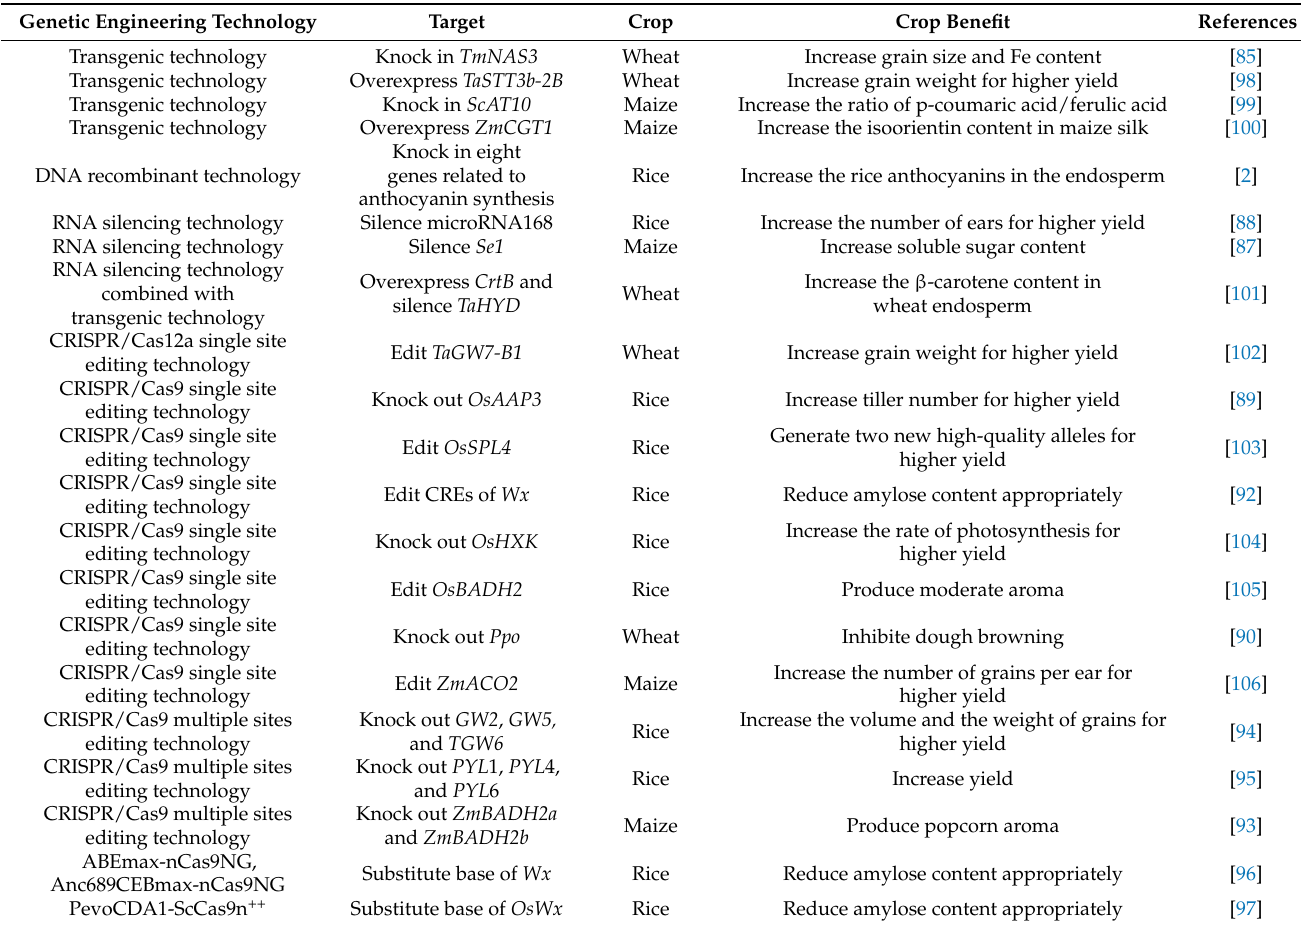
Table 2. Application of genetic engineering technology in improving crop yield and